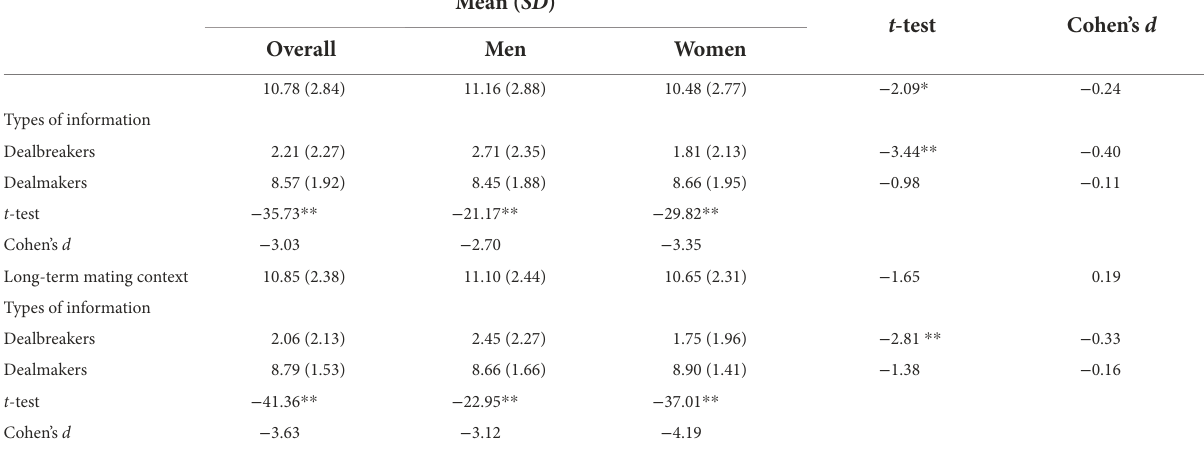
TABLE 3 Between- and within-subjects effects of participants’ sex and the presentation of dealbreakers or dealmakers on change in interest in short-term and long-term mating contexts (Study